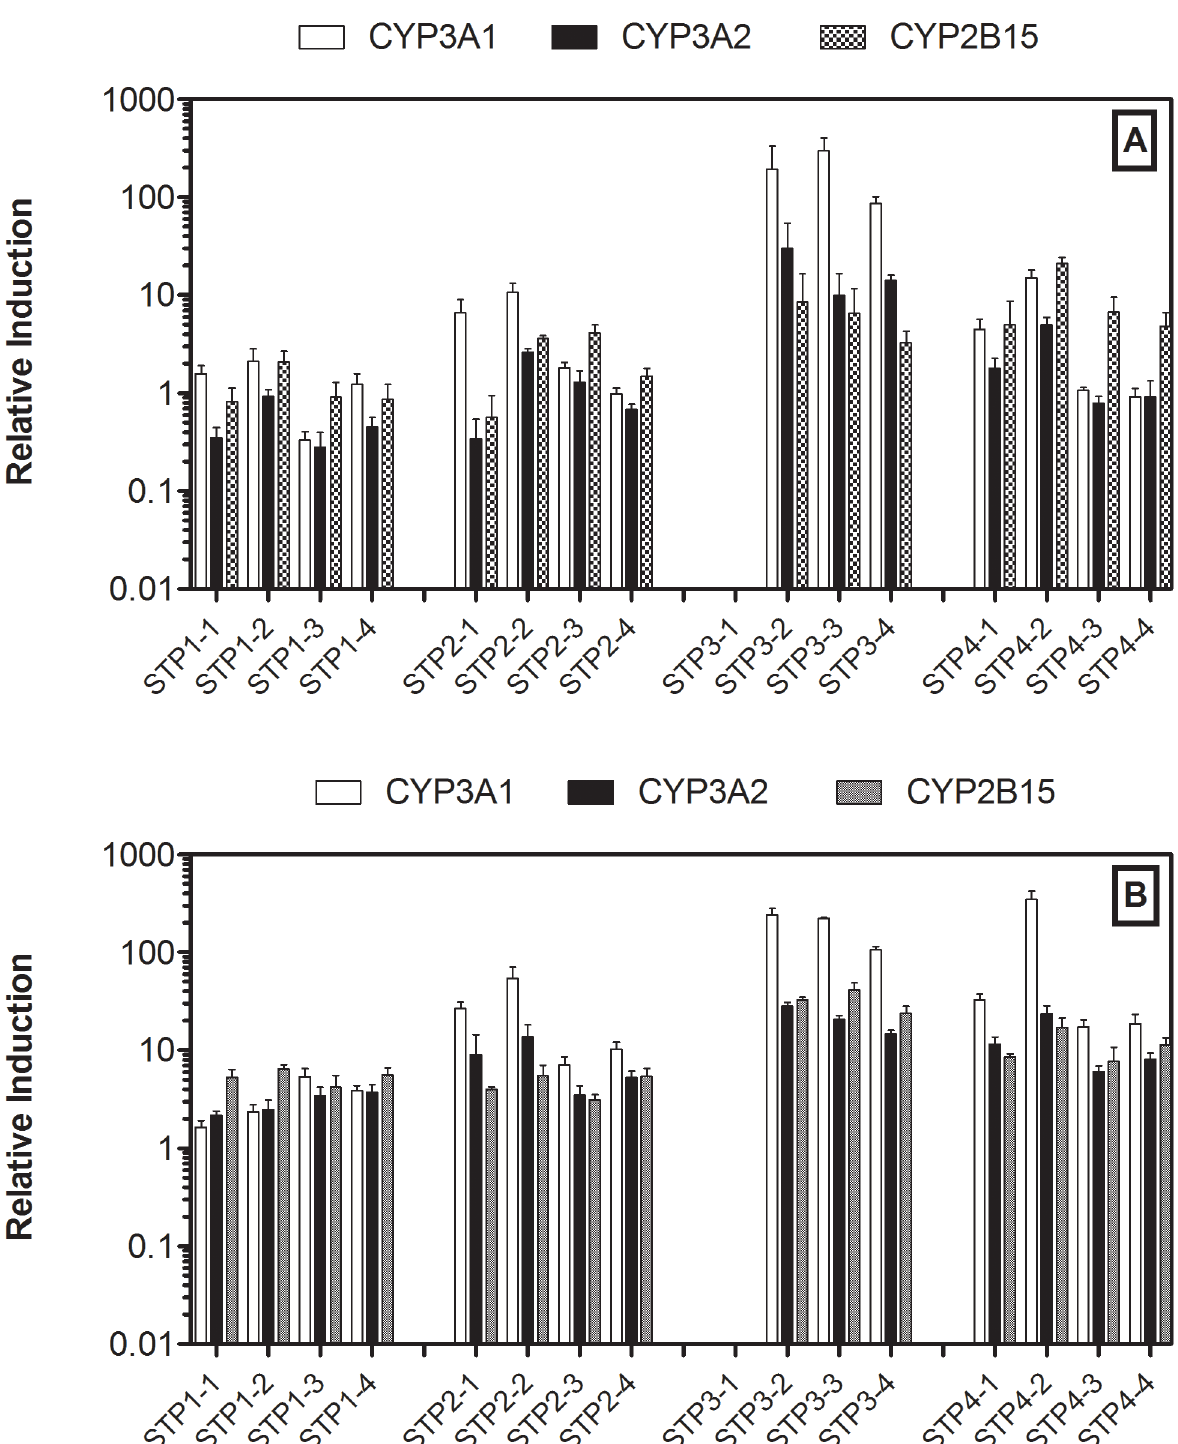
Fig 3. Comparison of CYP2B15 and CYP 3A gene expressions in rat hepatocytes exposed to wastewater extracts from STPs. A: Pre-monsoon; B: Monsoon. Data are reported as means ± SD (standard deviation). STPx-y: x is the type of STP; y is the treatment step [equalization (step 1), aeration (step 2), settling (step 3), and outlet (step 4)]. The data for STP3-1 were not available.